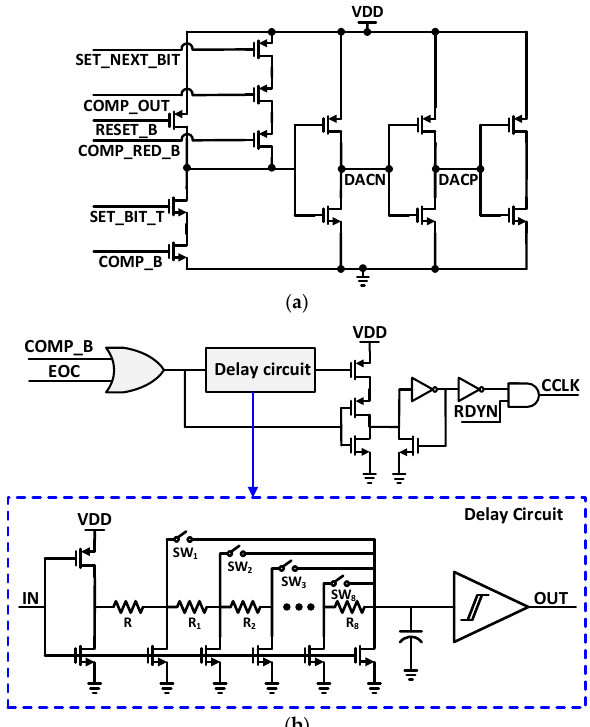
Figure 5. Main control block with DAC loop delay logic.